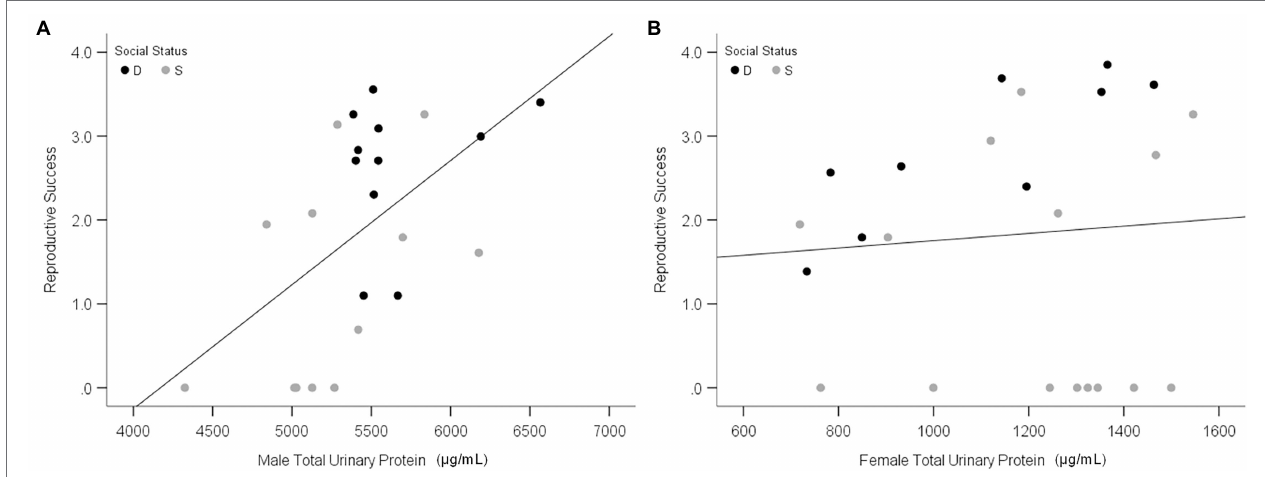
FIGURE 8 | Relationship between urinary protein output and reproduction success. Scatterplots show the total urinary protein output of males (A) and females (B) in relation to individual reproductive success in the large, seminatural enclosures. Black and gray data points indicate dominant (D) and subordinate (S) social status, respectively. Reproductive success was calculated as the Ln (number of offspring per mouse + 1). Adapted from Luzynski et al.